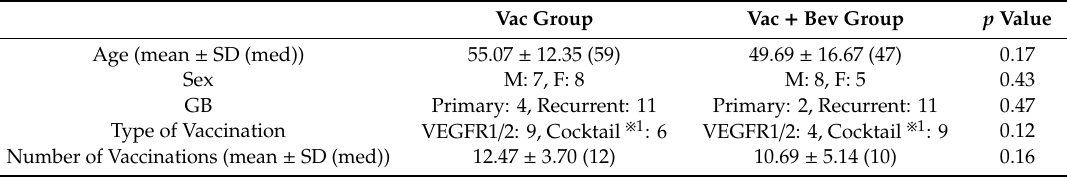
Table 1. Summary of patients’ general characteristics in Vac and Vac + Bev